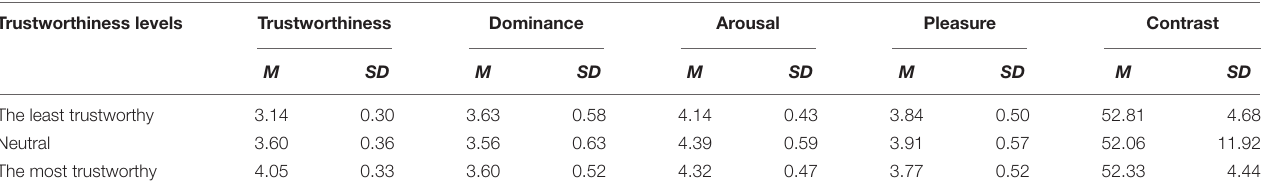
TABLE 1 | Mean and standard deviation of trustworthiness, dominance, arousal, pleasure, and contrast of the 66 faces. Trustworthiness levels